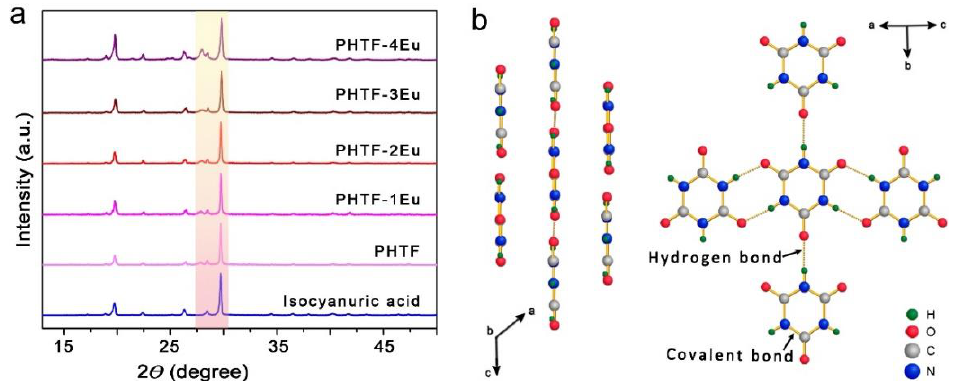
Figure 1. ( a ) Normalized PXRD patterns of PHTF, PHTF:Eu, and pure isocyanuric acid; ( b ) Scheme showing how an isocyanuric acid monomer connects to other neighboring in-plane or out-of-plane units through eight N – H···O H-bonds. Covalent bonds are shown as saffron yellow solid lines and H-bonds as yellow dotted lines.